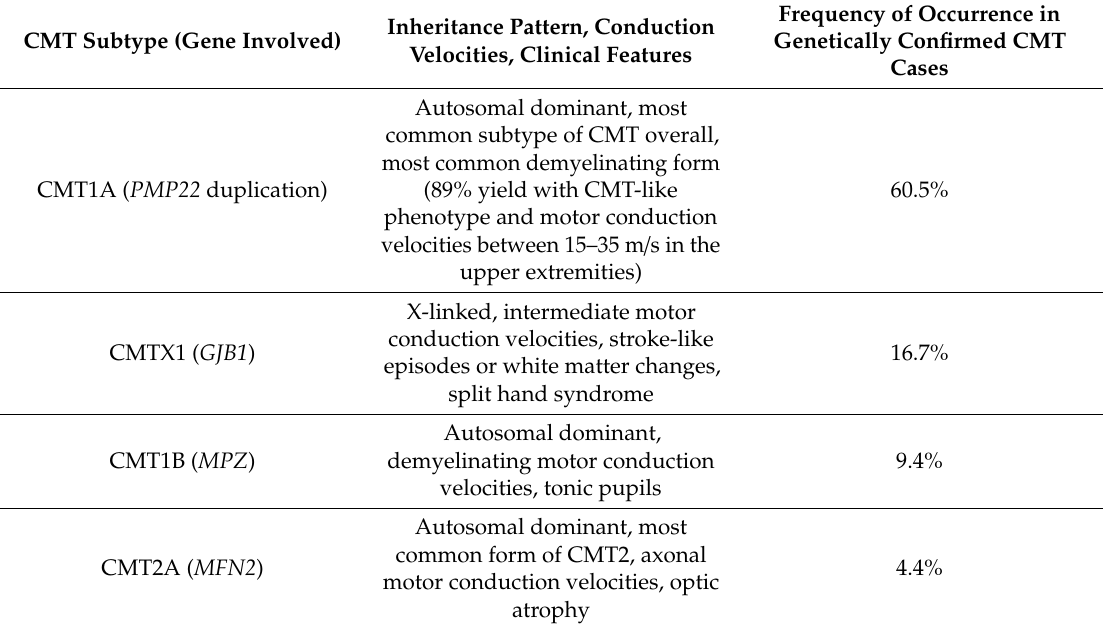
Table 1. Frequency * of the most common genetically Charcot-Marie-Tooth (CMT) mutations and their clinical